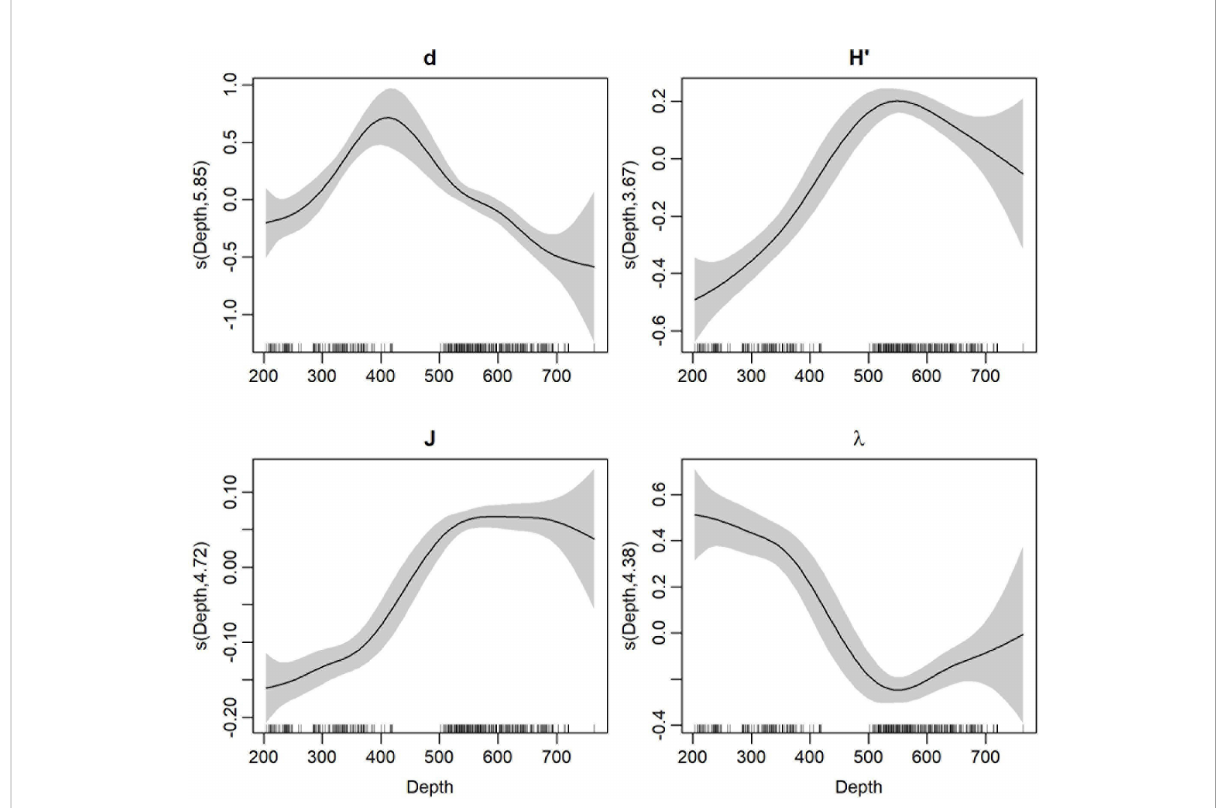
FIGURE 6 Fitted depth smooth effects for ecological indices. Tick marks on the x-axis are the observed data; y-axis represents the smooth effects with estimated degrees of freedom. Grey area corresponds to 95% con fi dence bands for smooths. d, Margalef richness; H ’ Shannon-Wiener diversity, Shannon-Wiener, J, Pielou evenness, L , Simpson